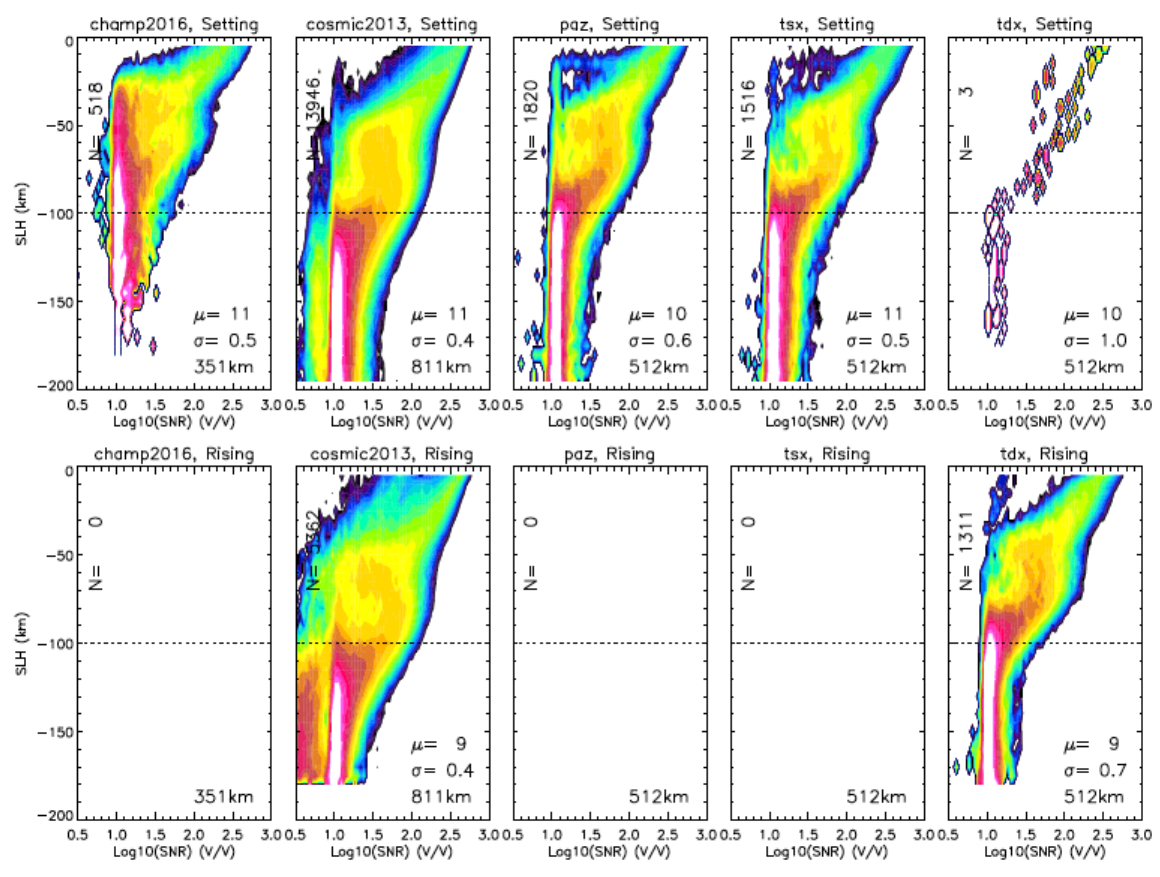
Figure A2. SNR statistics for the CHAMP, COSMIC-1, PAZ, TSX, and TDX receivers. The mean SNR values at H SL = −150 km are used to determine m (V/V). The 2007 CHAMP, 2009 COSMIC-1, 2020 PAZ, 2019 TSX, and 2019 TDX data are used in the analysis.